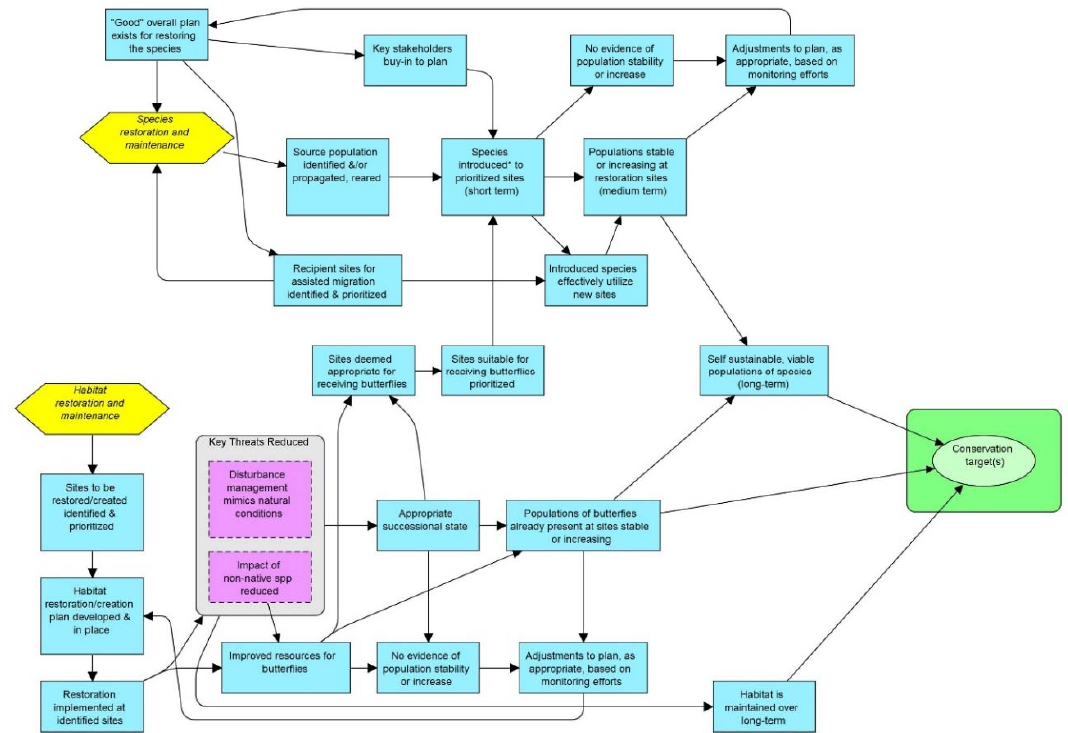
Figure 1. Example results chain developed through Miradi. The yellow hexagons represent a subset of the specific recovery strategies, blue boxes represent intermediate actions, pink boxes represent threat reduction result of intermediate actions, and green oval represents identified conservation target (e.g., organism, species assemblage, habitat, community, system). This particular example is for an at-risk butterfly recovery project in southern California, USA where the focal species require some level of regular habitat management.